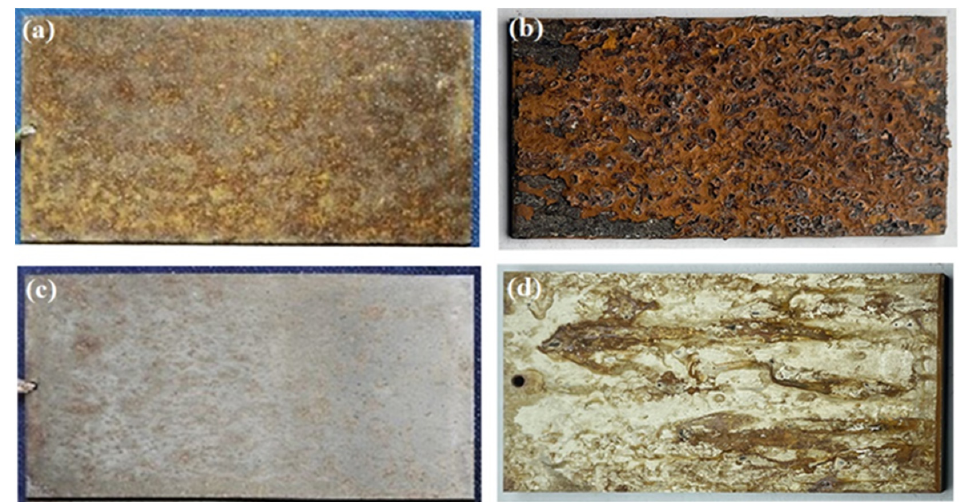
Figure 6. Comparison of corrosion morphology of two materials. Field exposure corrosion test for 2 years ( a ) and laboratory-accelerated corrosion test for 15 days ( b ) with 3Cr13; field exposure corro- sion test for 2 years ( c ) and laboratory-accelerated corrosion test for 15 days ( d ) with 00Cr12Ni10MoTi.